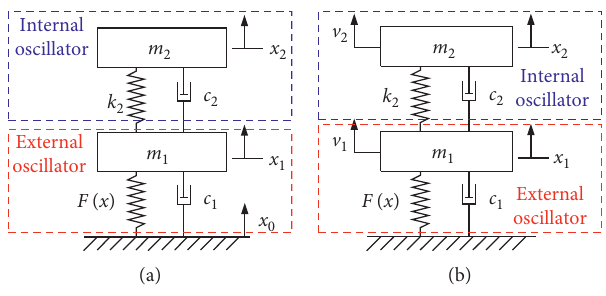
Figure 2: Nonlinear two-degree oscillator models of the packaging system. (a) Acceleration_pulse. (b) Velocity impact.